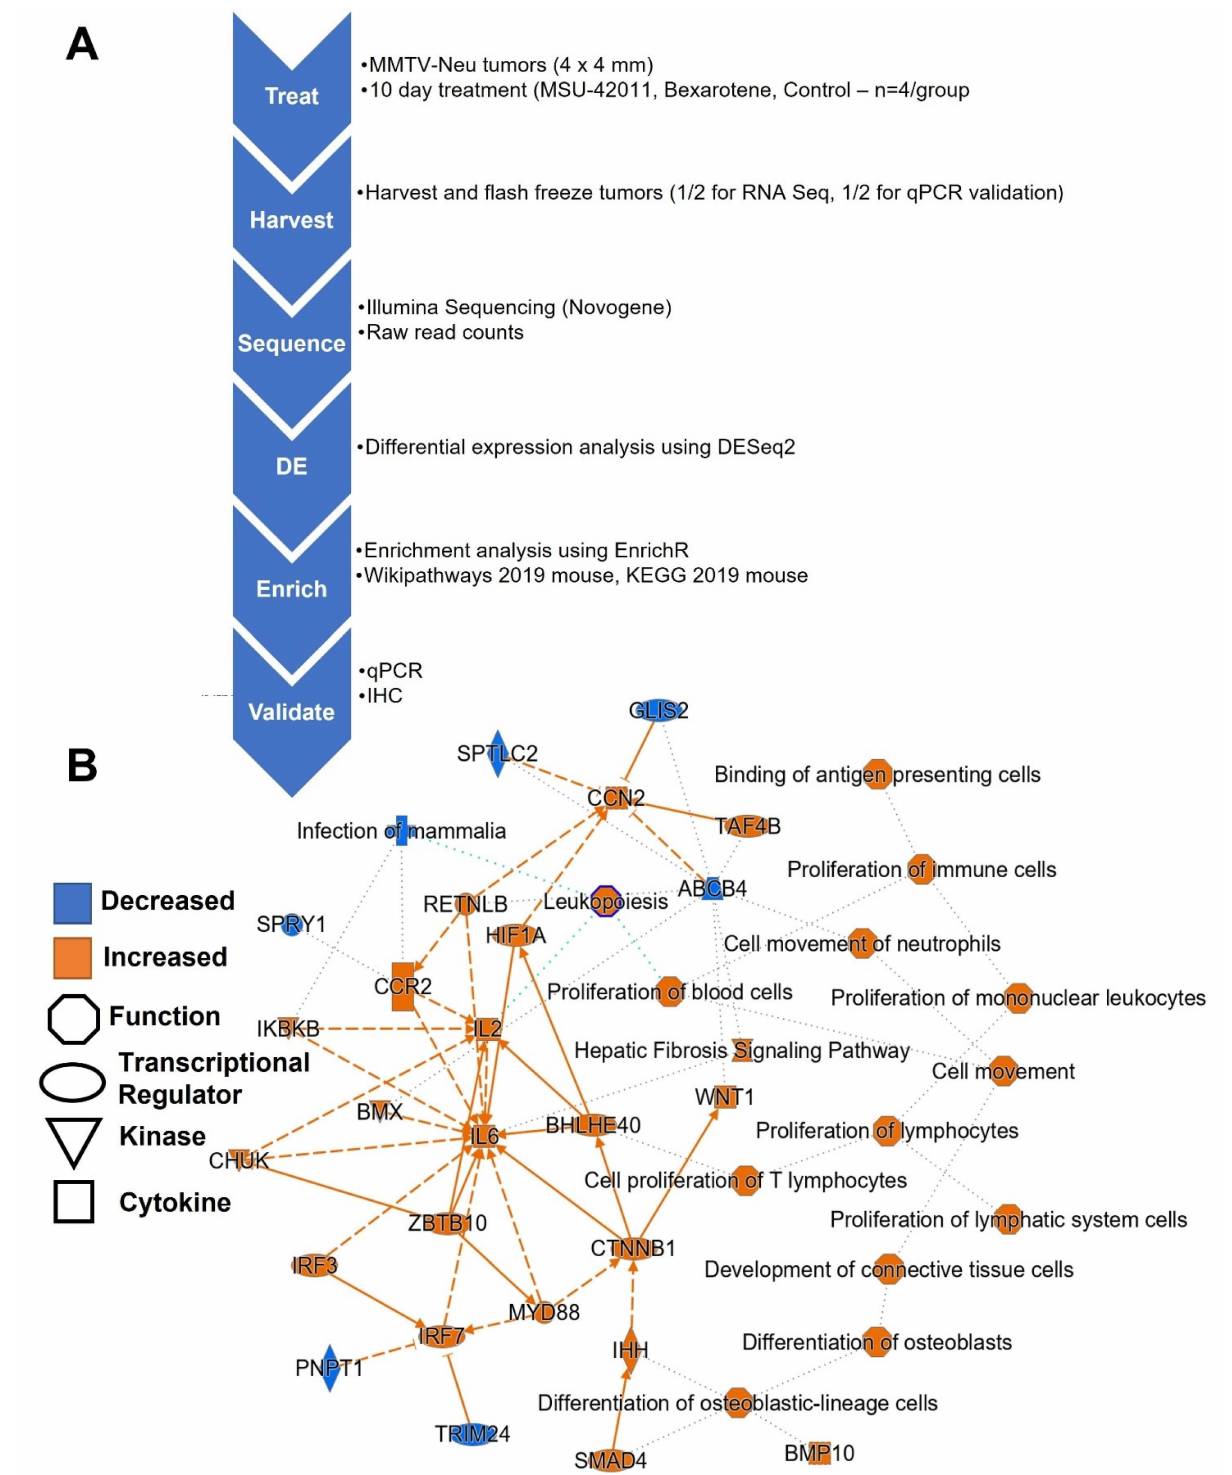
Figure 1. RXR agonists regulate pathways relevant in breast cancer. ( A ) Experimental flow diagram of RNA Sequencing studies. ( B ) Qiagen Ingenuity Pathway Analysis reveals a network of pathways differentially regulated by the RXR agonists bexarotene and